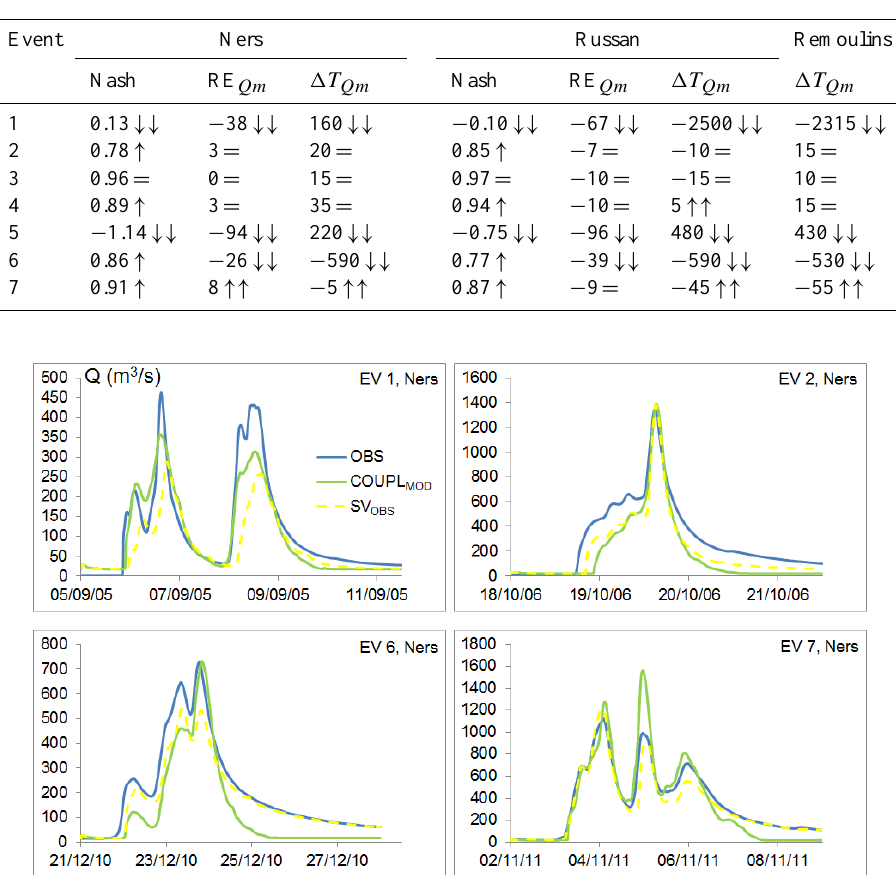
Hu2 index calculated every day by the SIM model of Météo- France (Habets et al., 2008), and estimating the soil moisture of the root layer (between 10 and 190 cm), is particularly in- teresting for estimating the S